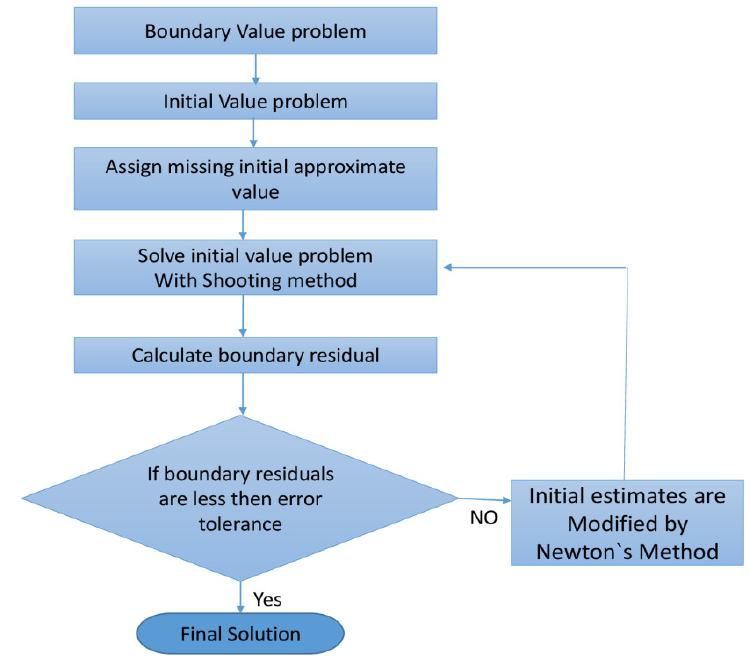
Figure 2. The flow diagram of RK4.